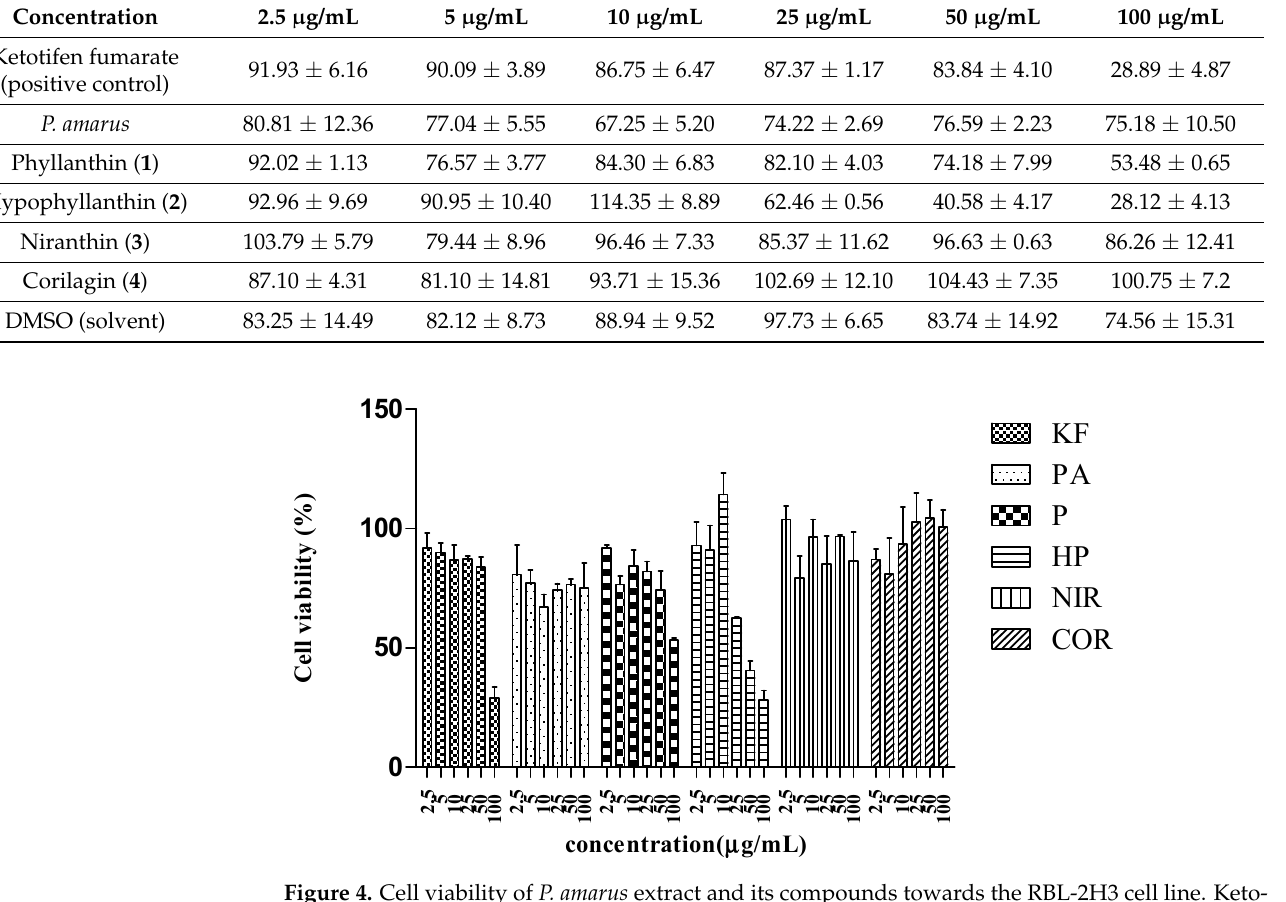
Figure 4. Cell viability of P. amarus extract and its compounds towards the RBL-2H3 cell line. Ke- totifen fumarate (KF), P. amarus (PA), niranthin (NIR), corilagin (COR), phyllanthin (P), hy- pophyllanthin (HP).